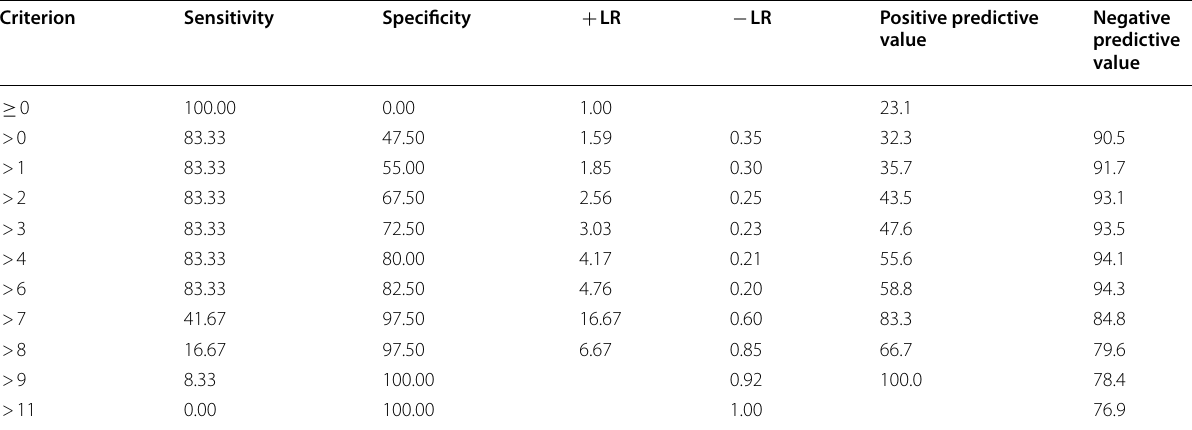
Table 3 ROC curves to detect the optimum cut‑off values of delta B lines for diagnosis of weaning‑induced pulmonary edema Criterion Sensitivity